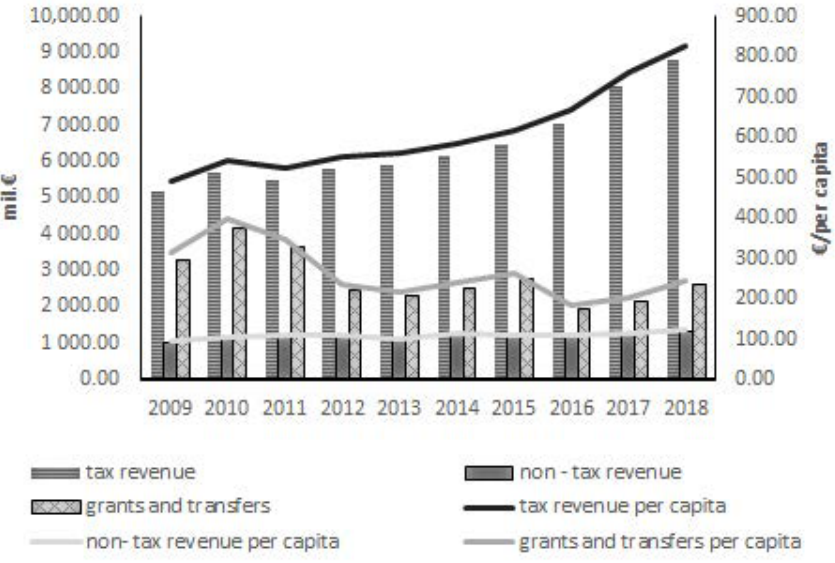
Figure 4. The development of individual categories of current revenues of the municipalities in Czech Republic in the time period 2009–2018, Source: Czech Statistical O ffi ce, own